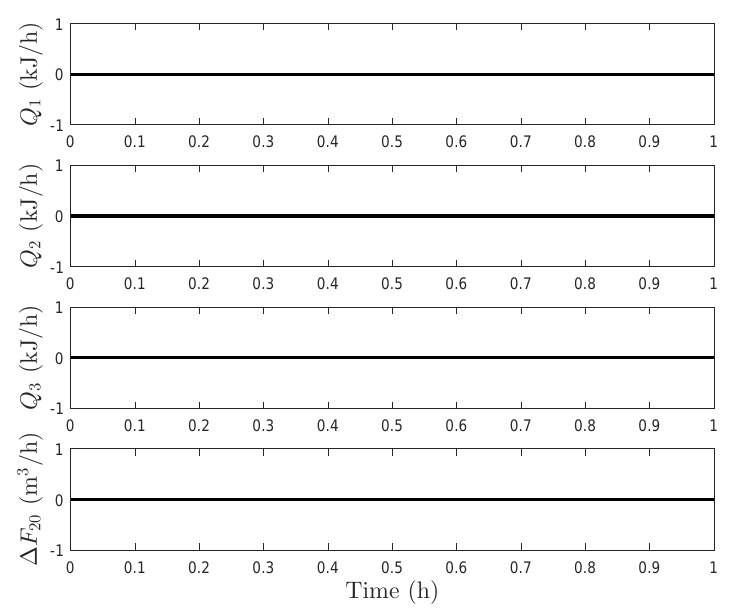
Figure 4. Manipulated inputs over 1 h of operation for the 2 CSTR-flash drum process under a cyberattacked EMPC provided the false state measurement x F 1 = ¯ x u